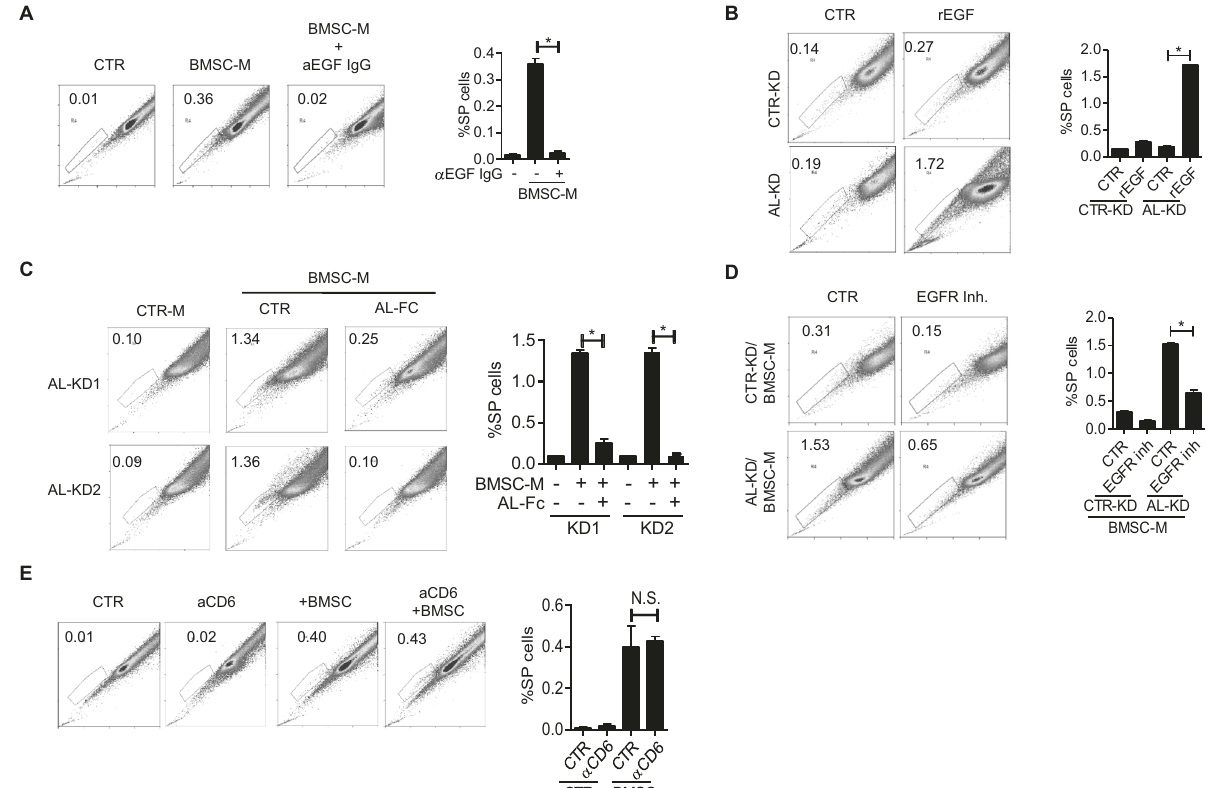
Fig. 2 ALCAM-EGF/EGFR axis regulates myeloma side population. A Hoechst staining of RPMI8226 cells in the presence of an EGF neutralizing antibody (10 μ g/ml) for 24 h and the result quanti fi cation (right panel). B Hoechst staining of CTR-KD or AL-KD RPMI8226 cells in the presence of recombinant EGF protein (10 ng/ml) for 24 h and the result quanti fi cation (right panel). C Hoechst staining of AL-KD1 and AL- KD2 RPMI8226 cells, cocultured with BMSC in the presence of ALCAM-Fc chimera fusion protein (AL-Fc, 0.5 μ g/ml) for 24 h and the result quanti fi cation (right panel). D Hoechst staining of CTR-KD or AL-KD RPMI8226 cells, cocultured with BMSC in the presence of EGFR inhibitor (ge fi tinib, 200 n Μ ) for 24 h and the result quanti fi cation (right panel). E Hoechst staining of RPMI8226 cells in the presence of CD6 antibody (10 μ g/ml) and the result quanti fi cation (right panel). Data are the mean of three independent experiments in three replicates. * p <